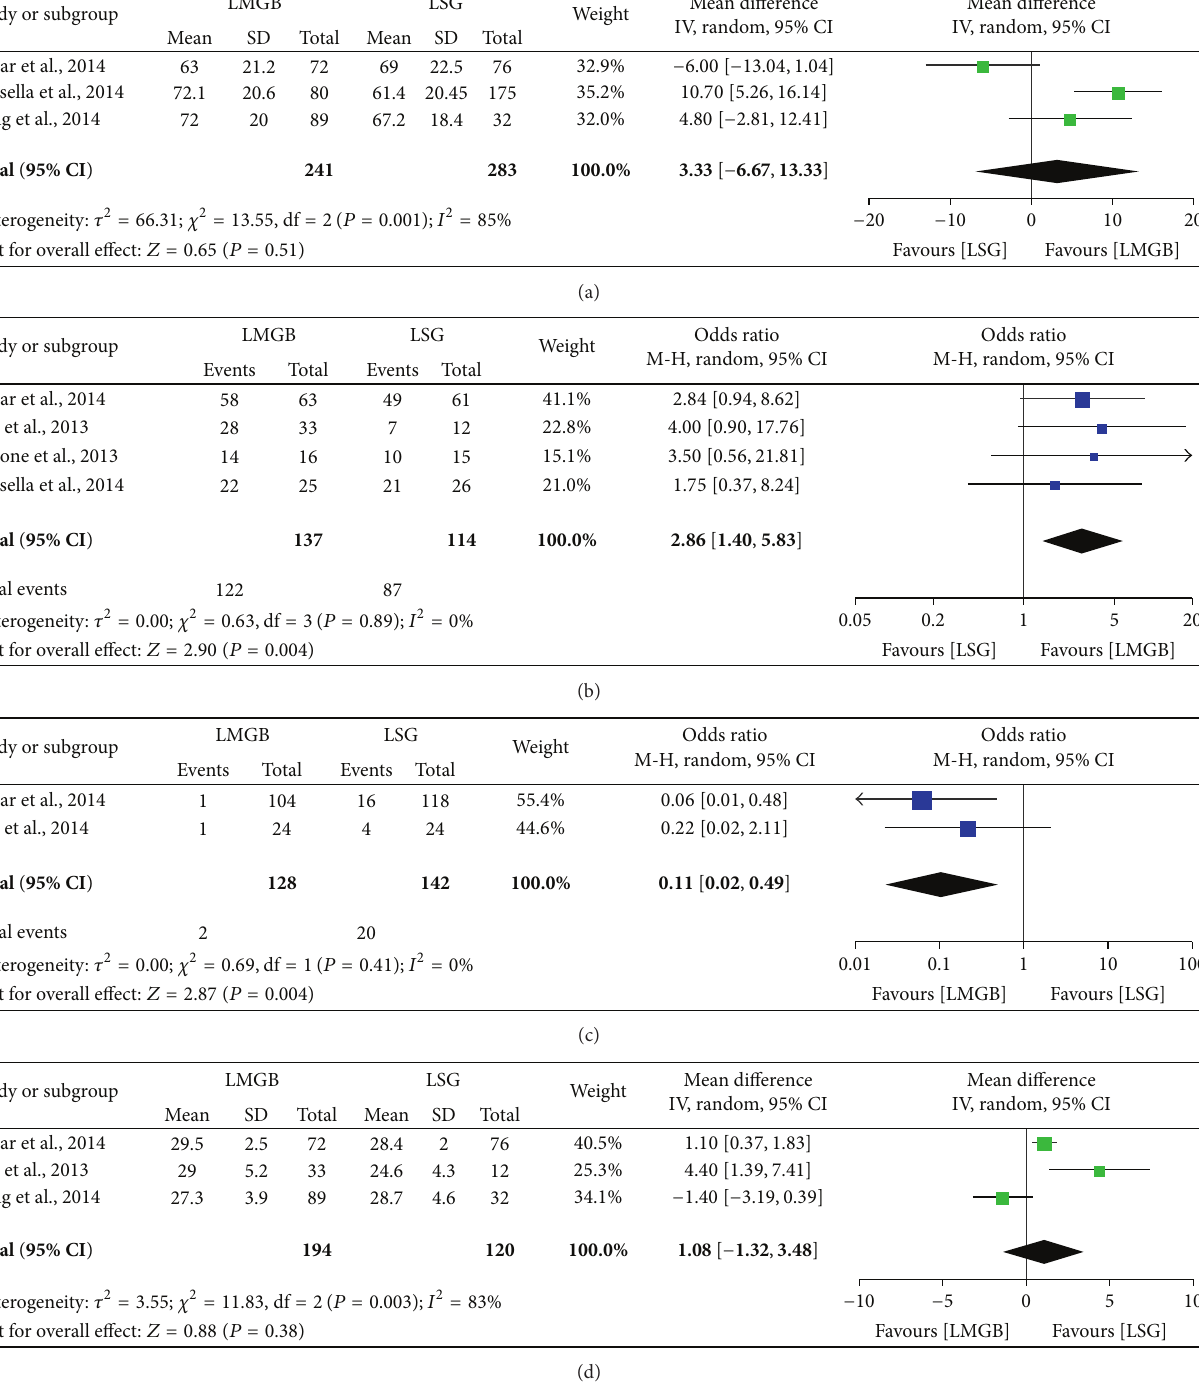
Figure 3: Meta-analysis comparing LMGB with LSG. (a) 1-year postoperative %EWL. (b) Overall remission rate of T2DM. (c) Revision surgery rate. (d) 1-year postoperative